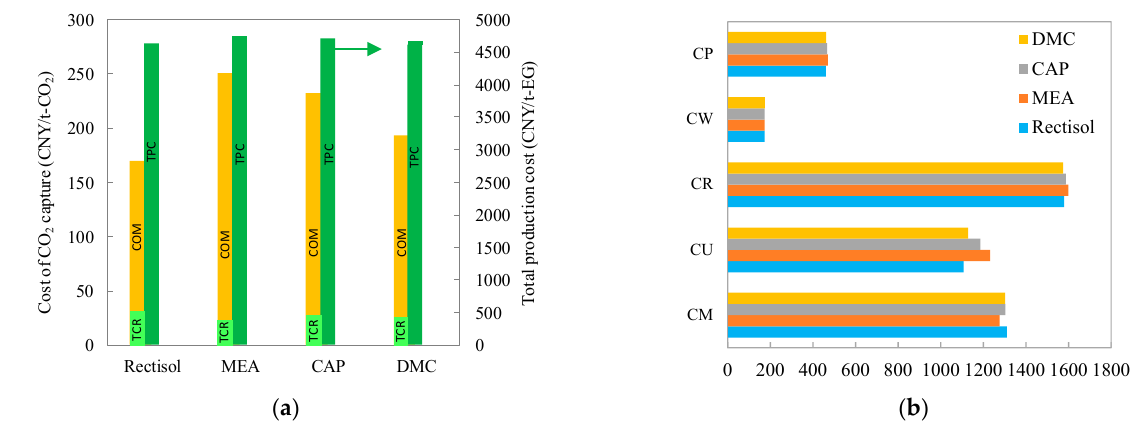
Figure 10. ( a ) Total production cost, ( b ) production cost compositions of the CTEG process with different CO 2 capture technologies.